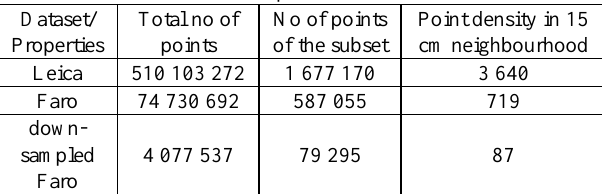
Figure 7. The down-sampled subset scanned by the Faro scanner Table 1. Properties of datasets